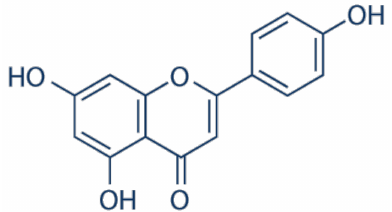
Figure 1. The chemical structure of apigenin.